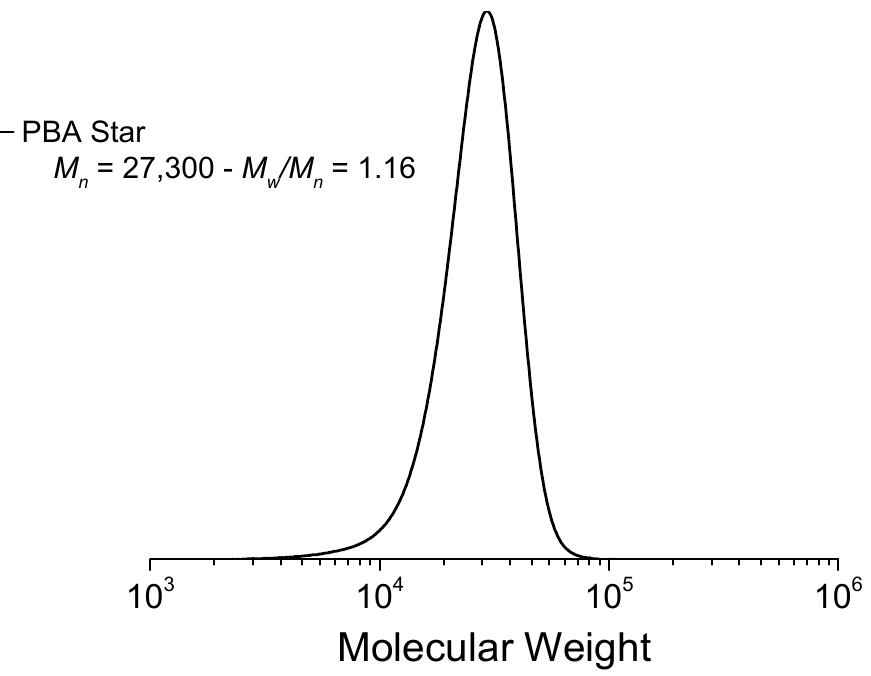
Figure 1. GPC trace of the PBA 4 Br polymer stars. The molecular weight is given relative to linear PMMA standards in THF. The polymer stars were prepared by photoinduced ATRP using a molar ratio of [BA]/[4f-BiB]/[CuBr 2 ]:[Me 6 TREN] = 400:1:04:0.24 in 16/64 v / v % DMF/Anisole. The reaction